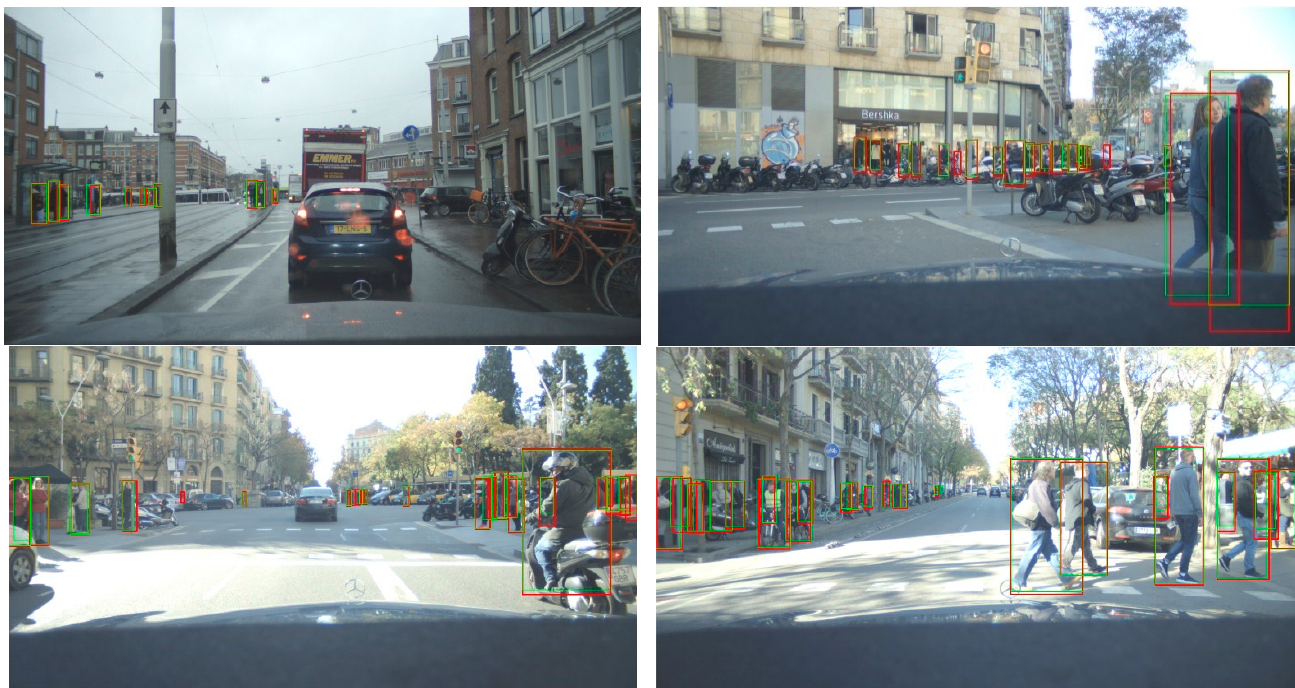
Figure 10. Example detection results of our proposed DAGN method on the ECP validation set. Green boxes, ground truth and red boxes, detection results. We visualized the detection boxes with the confidence score larger than 0.3. Table 5. Comparisons with the state-of-the-art methods in terms of log average miss rate on the ECP test set. Red color values denote the best results.